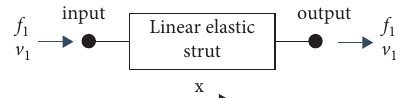
Figure 3: Transfer matric representation of a linear elastic